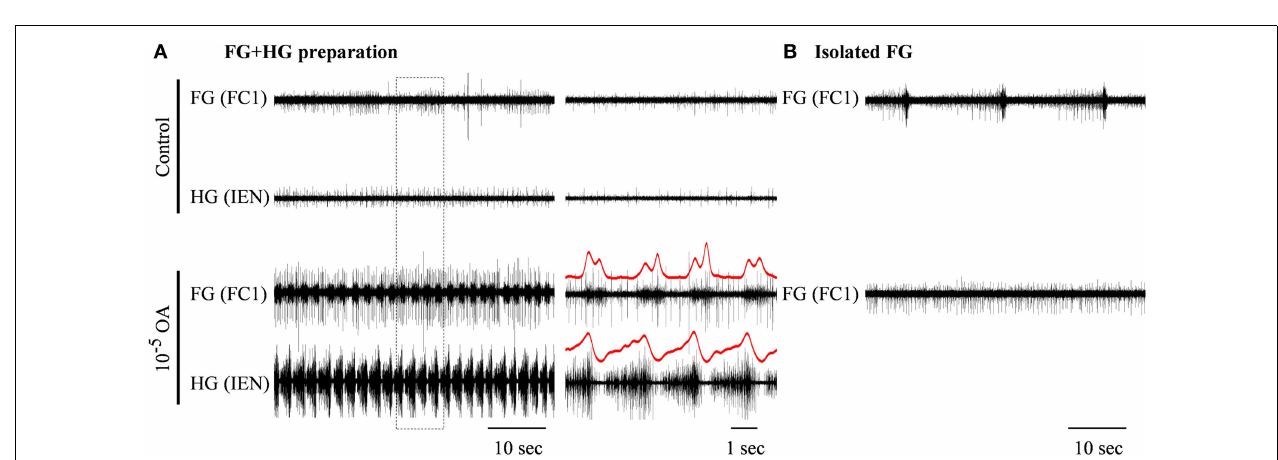
FIGURE 4 |The effect of the HG on the rhythmic burst frequency of the FG. (A) Upper trace: extracellular recording from the FG efferent nerve, FC1, in an in vitro preparation of interconnected FG + HG. RN cut (indicated by a